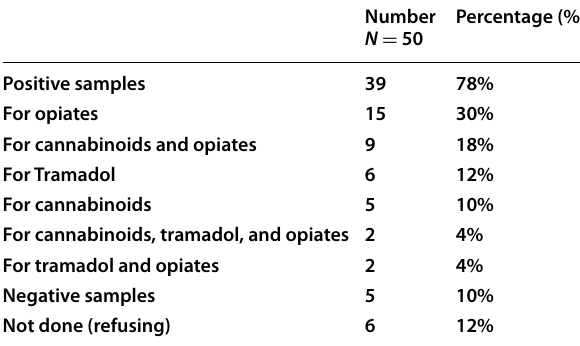
Table 7 Results of urine drug